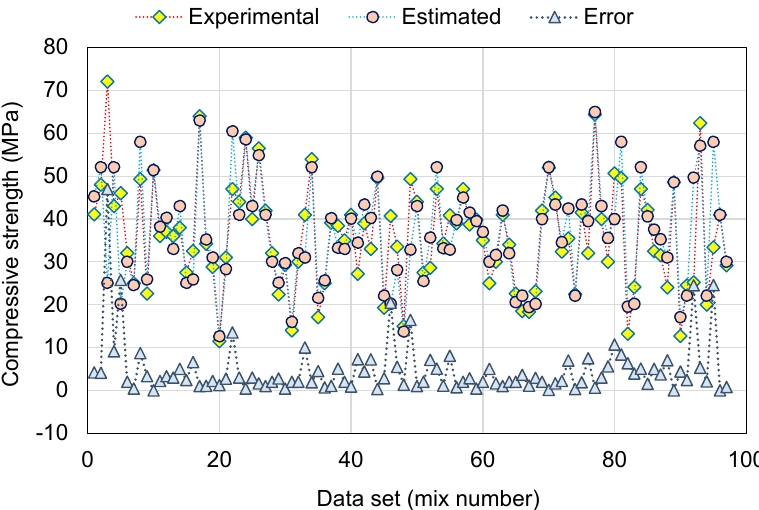
Figure 9. Distribution of experimental, estimated, and error values for the support vector machine model.